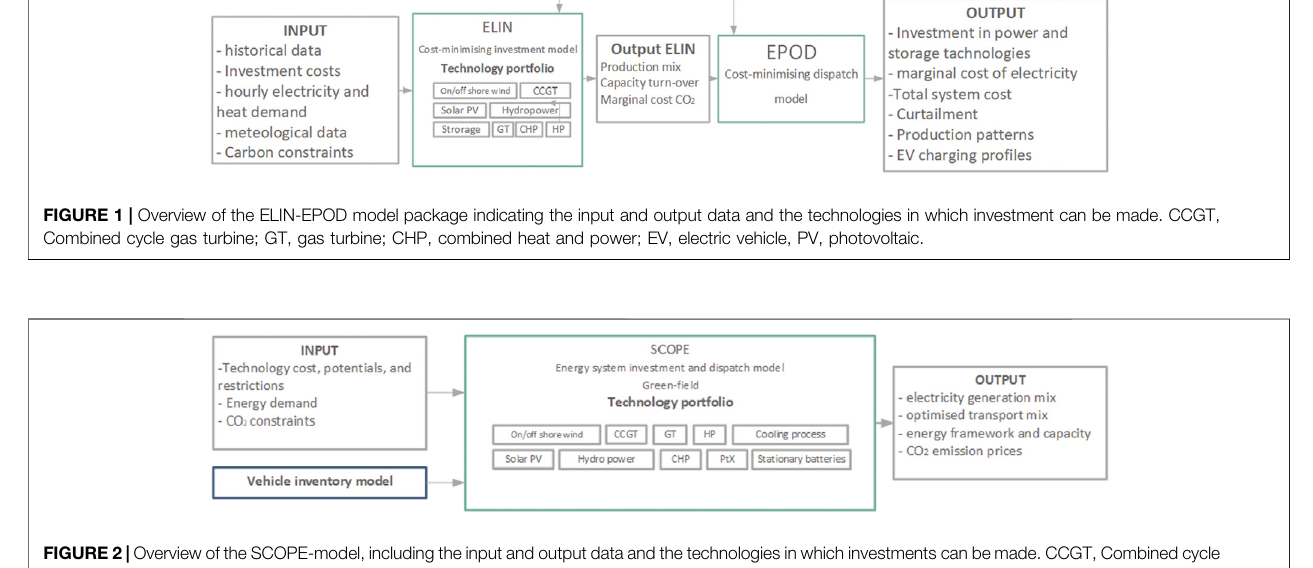
Frontiers in Energy Research |